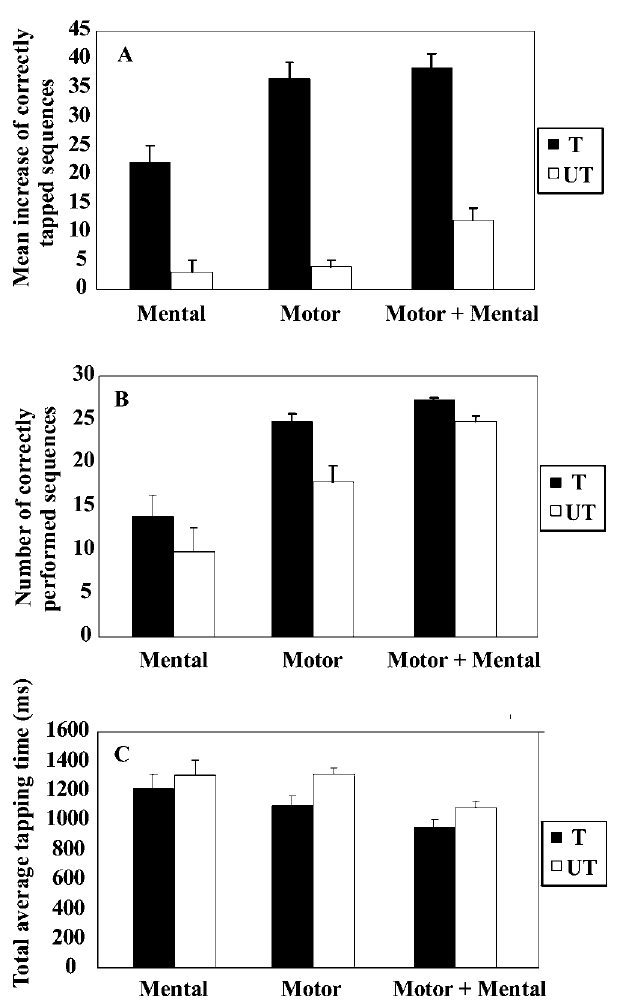
Figure 1 | Behavioral performances following motor, mental, or combined motor and mental training. All measures revealed a similar pattern, where combined motor and mental training and motor training only were more effective compared to mental training. There was a non-signifi cant trend towards an additive effect of combining motor and mental training. Moreover, combining motor and mental training resulted in performance increase on the untrained sequence (transfer). Data for the trained (T) and the untrained (UT) sequences are presented for (A) the increase in tapping performance outside the scanner, (B) the mean number of correctly tapped sequence during fMRI- scanning, and (C) the average tapping time during the fMRI-scanning. The bars denote standard